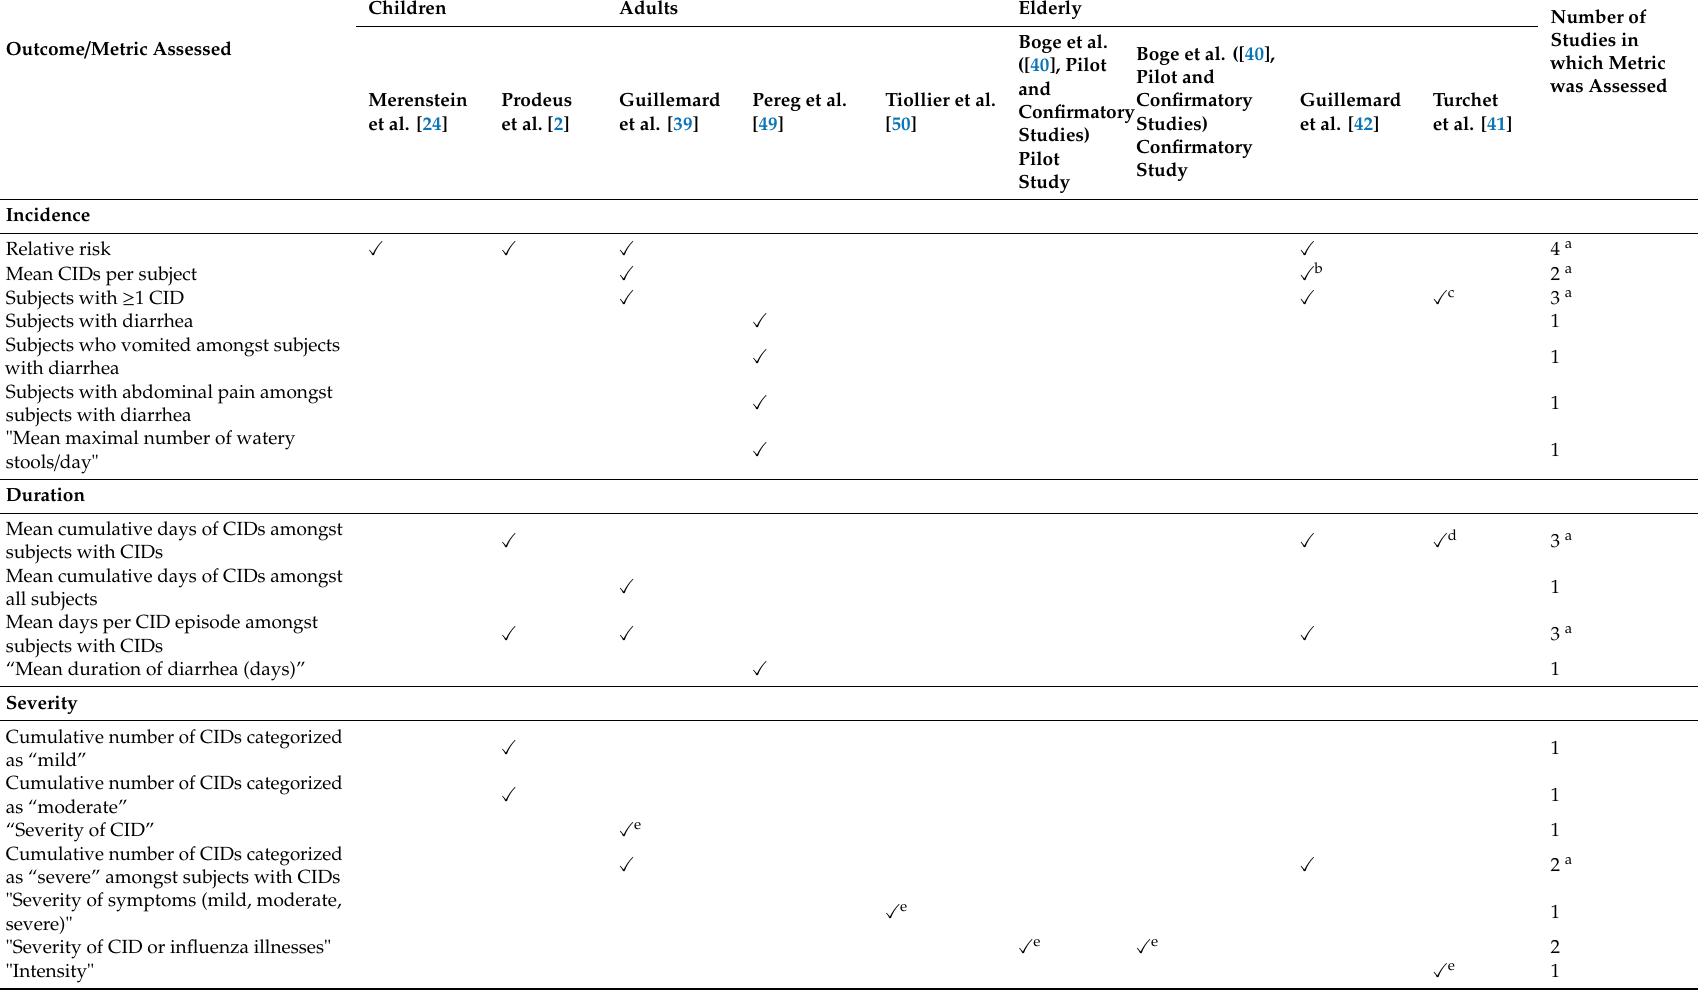
Table 4. Map of outcomes and metrics assessed across